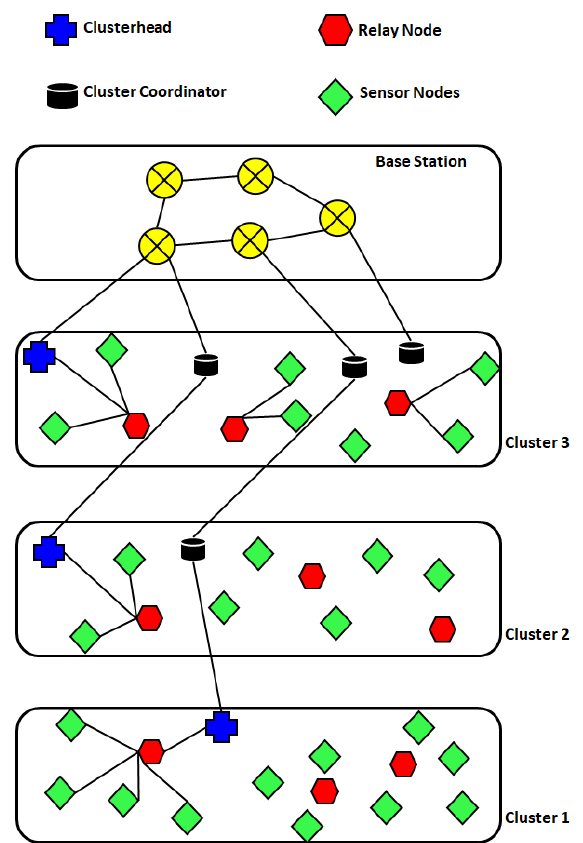
Figure 6. Network model.